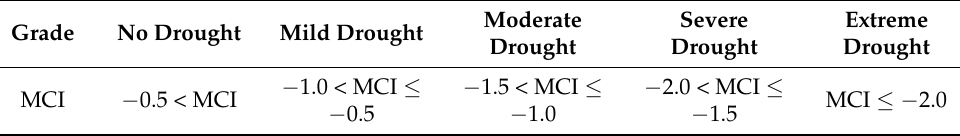
Table 1. Classification table of meteorological drought composite index grades